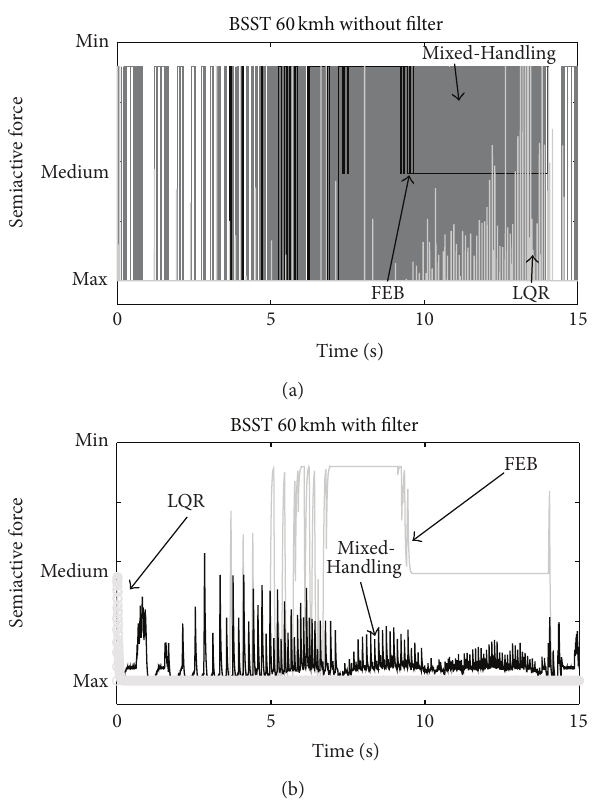
Figure 9: Static and dynamic response of the damper in BSST for constant speed and three controllers.